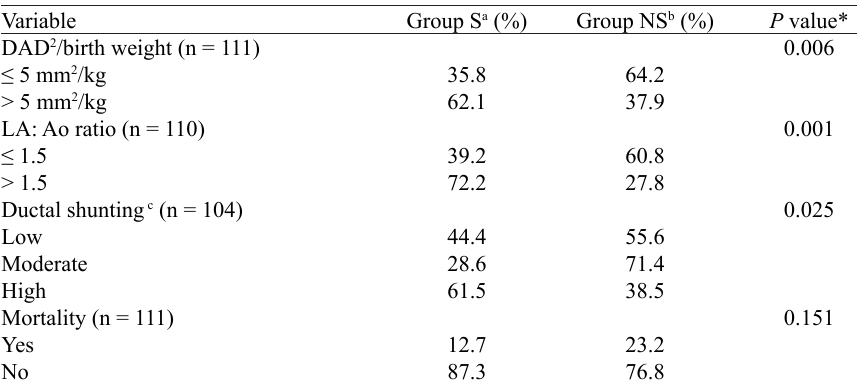
Table 2. Association between the indication for surgical closure of patent ductus arteriosus in a population of preterm neonates (N = 115) and the variables quotient of diameter of ductus arteriosus (DAD) 2 and birth weight, left atrial-to-aortic root diameter ratio (LA:Ao), ductal shunting and